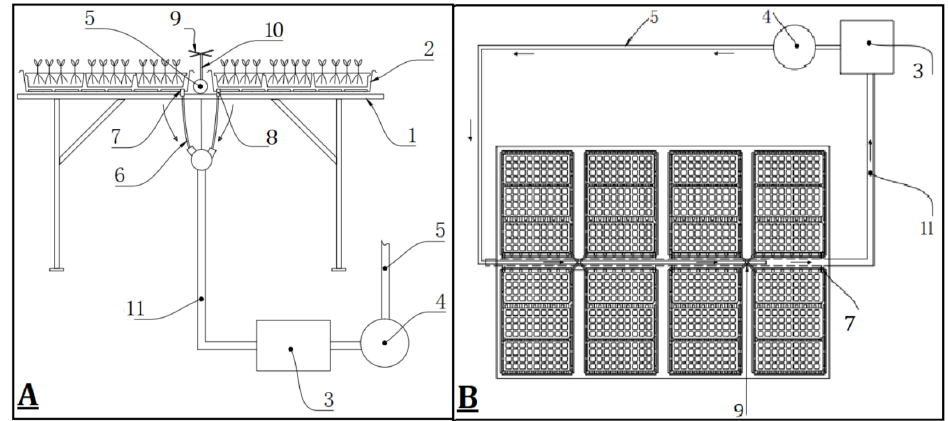
Figure 1. Lateral ( A ) and top ( B ) view of ebb-and-flow nursery raising system. 1-nursery frame; 2-ebb-and-flow tray; 3-water reservoir; 4-disinfection equipment; 5-inlet main pipe; 6-drainage branch pipe; 7-drainage hole; 8-filtering parts; 9-inlet branch pipe; 10-five-way connector; 11-drainage main